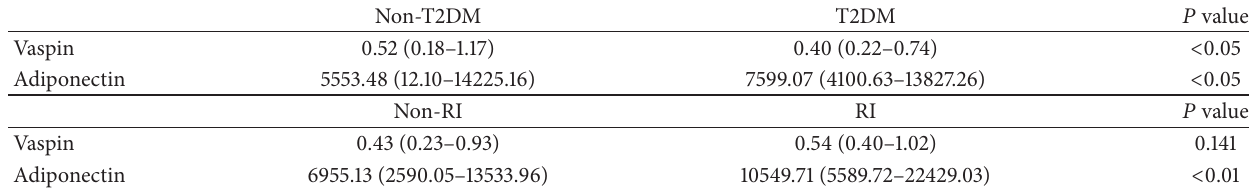
Table 2: Comparisons of serum vaspin and adiponectin divided by T2DM and RI.